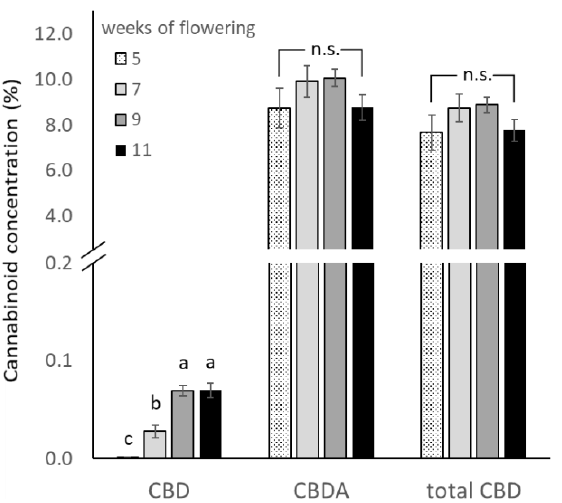
Figure 3. Least square means (± standard error) of CBD, CBDA and total CBD concentration (in % of inflorescence dry weight) for the four harvest times (weeks of flowering). For CBD values, means with at least one identical letter are not significantly different from each other according to Fisher´s LSD test with α = 0.05. Values for CBDA and total CBD are not significantly (n.s.) different from each other according to global F-test.